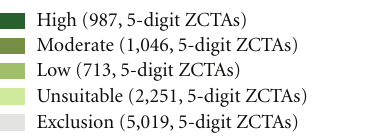
Figure 4: Opportunity zones for woody biomass-using facilities identified by landscape suitability index in the 13-state study region.